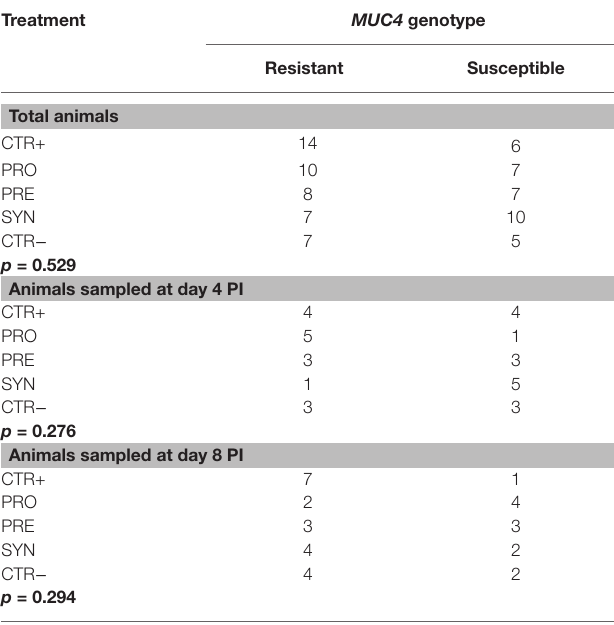
TABLE 2 | Distribution of resistant and susceptible animals for MUC4 gene in each experimental group.